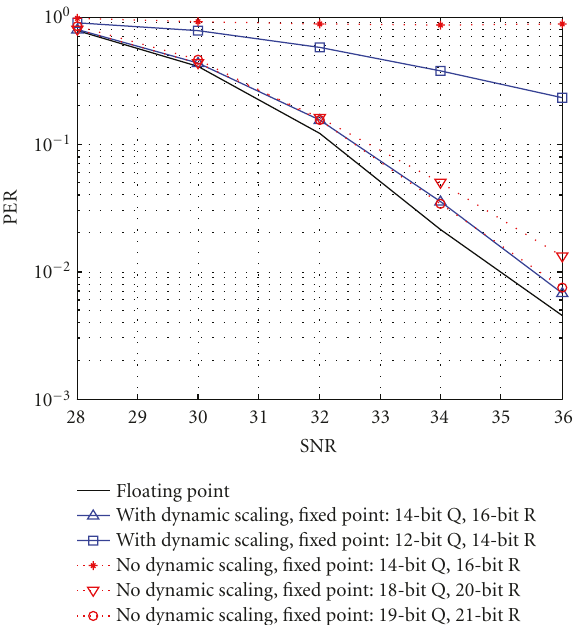
Figure 5: Impact of dynamic scaling on Gram-Schmidt